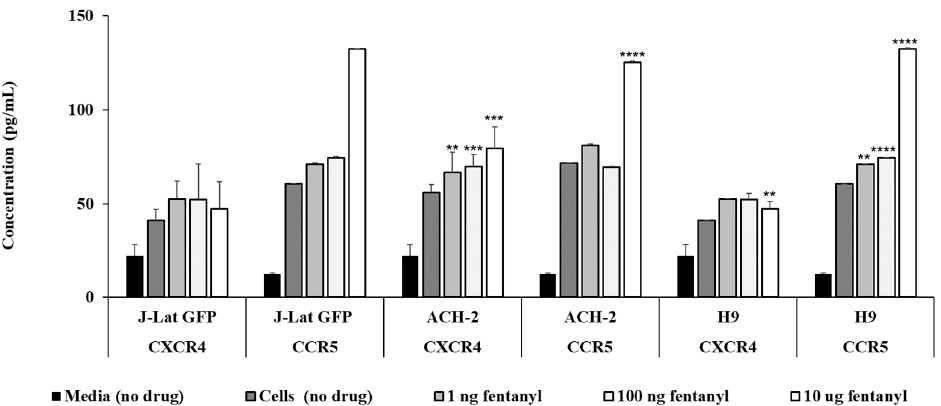
Figure 6. Lymphocyte cell lines were seeded at ~2 × 10 5 cells per well. Fentanyl at three di ff erent concentrations was added. After incubation with the drug for 24 h, quantification of CXCR4 and CCR5 protein levels (pg/mL) was estimated with ELISA in cell lysates. ANOVA for dose effect on CXCR4: p = 0.127 for J-Lat GFP, p = 0.0109 for ACH-2, and p = 0.0026 for H9. ANOVA for dose effect on CCR5: p < 0.0001 for J-Lat GFP, ACH-2, and H9. ** p < 0.01; *** p < 0.001; **** p < 0.0001.